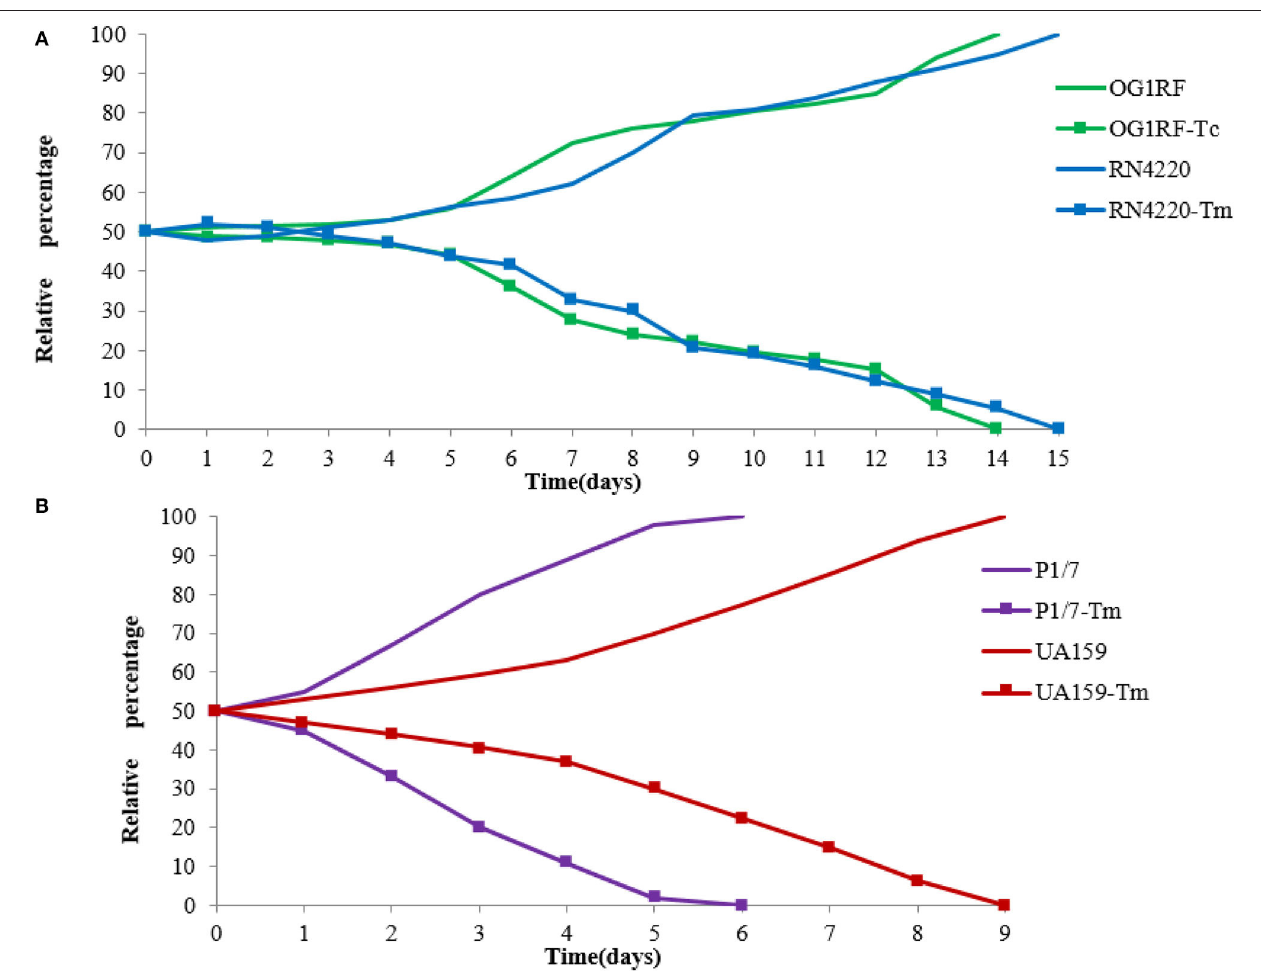
FIGURE 5 | (A) Growth competition experiments between E. faecalis OG1RF and E. faecalis OG1RF-Tc, S. aureus RN4220 and S. aureus RN4220-Tm. (B) Growth competition experiments between S. suis P1/7 and S. suis P1/7-Tm, S. mutans UA159 and S. mutans UA159-Tm. The initial ratio of the recipient strain carrying pE165 to the original recipient strain was 1:1. The results above were averagely calculated from four independent